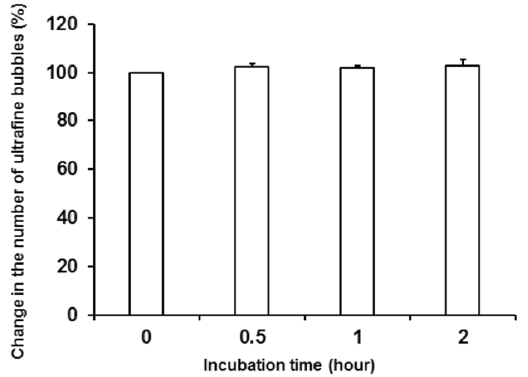
Figure 4. Albumin NBs stability over time. Total number of NBs remained unchanged for at least 2 hours, which was approximate duration for cavitation experiment. Errors bars represent the standard deviation with N = 3. Student t-test does not indicate a significant change in the percentage of bubbles compared to their initial number (at t =